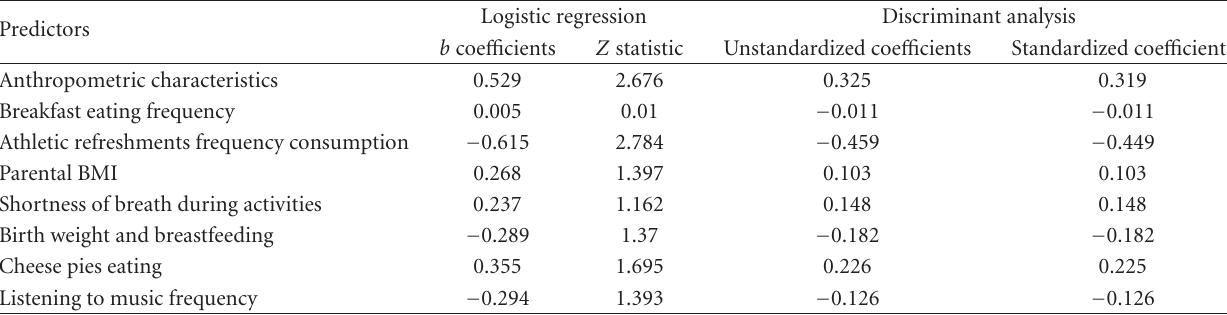
Table 1: Predictors, standardized, and unstandardized coe ffi cients for the discriminant analysis model and logistic regression model.